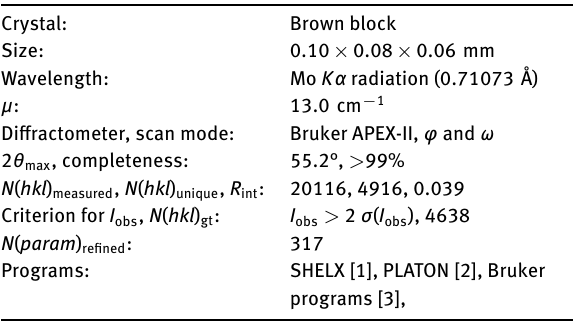
Table 1: Data collection and